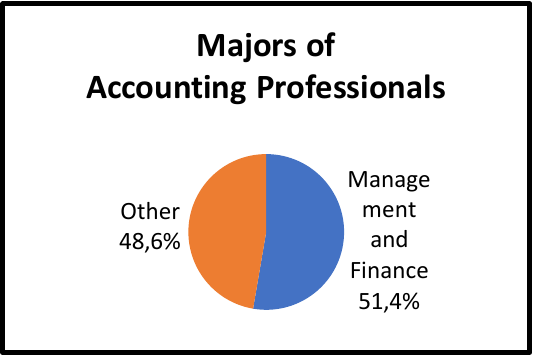
Figure 2. Majors of Accounting Professionals